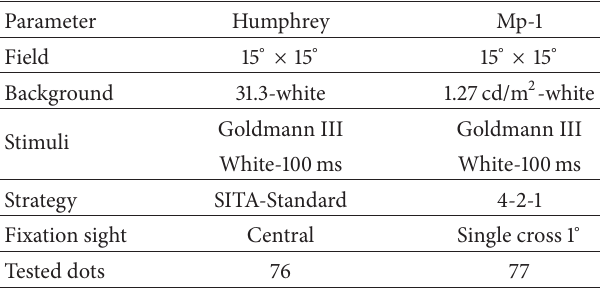
Table 1: Parameters used with both Mp-1 and Humphrey perimetry methods.